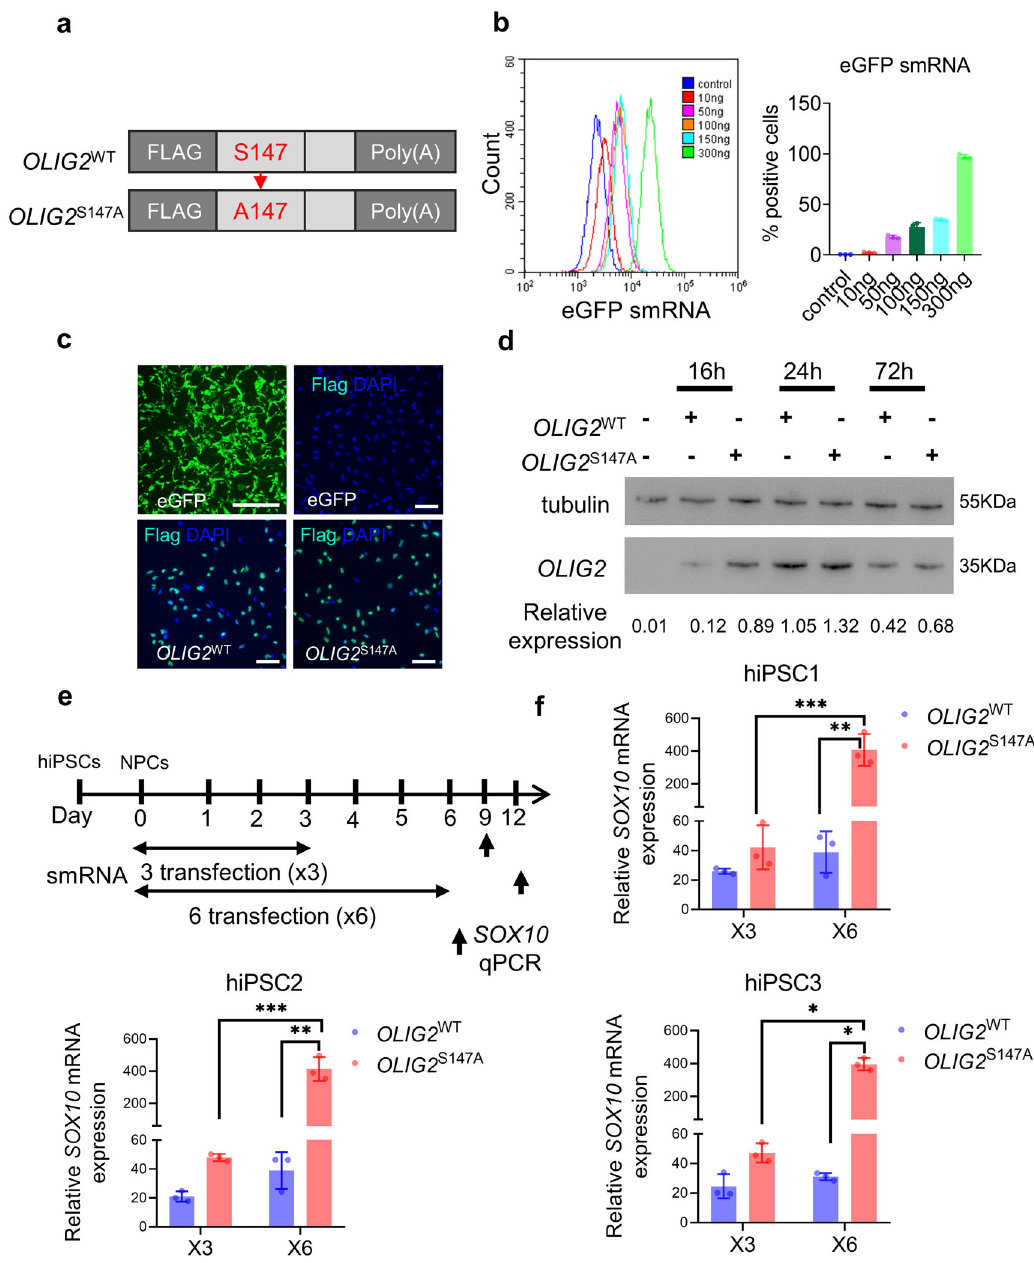
Fig. 1 An smRNA coding OLIG2 with phosphosite modi fi cation enhances protein expression and can induce differentiation into oligodendroglial lineage cells. a Diagram of the smRNAs encoding wild-type ( OLIG2 WT ) and phosphosite-modi fi ed OLIG2 ( OLIG2 S147A ). b Analysis of the smRNA transfection ef fi ciency in hiPSC-derived NPCs transfected with 10, 50, 100, 150, and 300 ng of eGFP smRNA at 24 h posttransfection. A representative overlay histogram is presented. The transfection ef fi ciency of NPCs treated with 300 ng of eGFP smRNA was greater than 95% ( n = 3). c hiPSC-derived NPCs were transfected with eGFP, OLIG2 WT or OLIG2 S147A (3XFlag-tagged) smRNA as indicated. Twenty-four hours after transfection, fl uorescence microscopy showed a large number of eGFP + or Flag + cells (DAPI: nuclei; scale bar, 200 μ m). d hiPSC1-derived NPCs were transfected with smRNA, and total proteins were harvested at the indicated time points for western blotting for OLIG2. The fold change in protein expression normalized to tubulin expression is shown below each lane. The representative quantitative data are from three independent experiments. e hiPSC-derived NPCs underwent three (×3) or six (×6) daily smRNA transfections. Total RNA was isolated for qPCR analysis of SOX10 expression on day 9 and day 12. f qPCR analysis of SOX10 mRNA expression in three different hiPSC lines at 3 days after smRNA transfection. OLIG2 S147A smRNA more potently induced the expression of the downstream target gene of OLIG2 ( SOX10 ) than wild-type smRNA ( n = 3; * p < 0.05, ** p < 0.01 and *** p < 0.001 using two-tailed Student ’ s t the reduced growth factor Matrigel/laminin, and SOX10 mRNA expression of a OL lineage marker gene ( SOX10 ) than OLIG2 WT smRNA in hiPSC2- and hiPSC3-derived NPCs (Fig. 1f). Type I expression was measured. The qPCR results suggested that six interferon (IFN) is considered a marker for antiviral defense daily transfections of OLIG2 S147A induced 9.8-fold higher SOX10 responses mediated by interferon- γ - and NF-kB-dependent mRNA expression than three daily transfections in hiPSC-derived pathways in mammalian cells 26 . The expression of the signaling NPCs. Similarly, we found that OLIG2 S147A smRNA drove higher